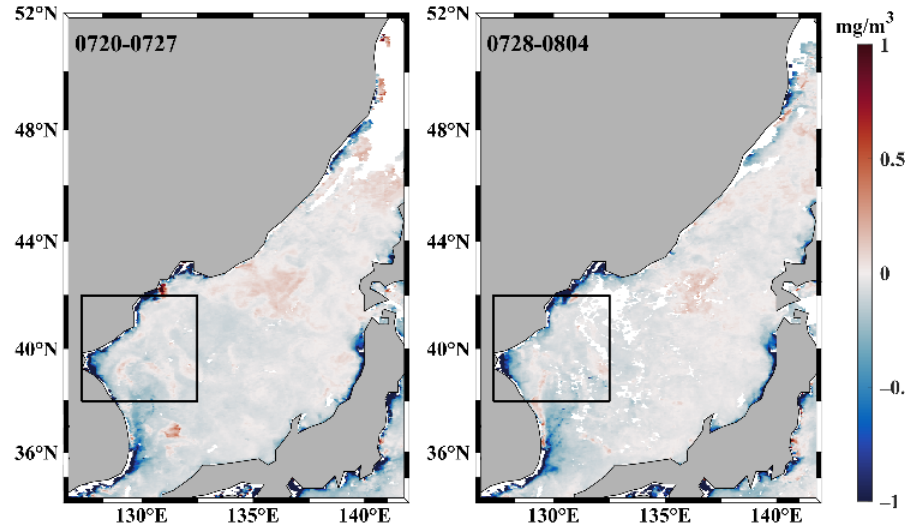
Figure 11. CHL anomaly (color shading, units: mg/m 3 ) from 20th July to 4th August 2021, relative to the climatology (1997–2021). The black box is the study area.